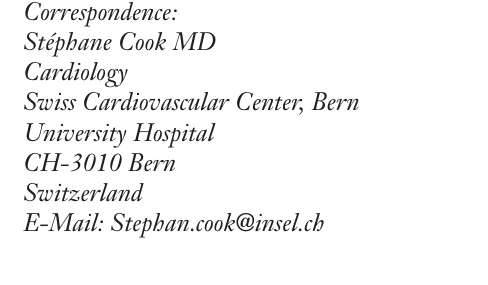
Scheme by which pathological nitric oxide homeostasis can cause metabolic syndrome X. ADMA indicates, asymmet- ric dimethyl arginine (or similar endoge- nous methylated arginines). Redrawn and adapted from Cook et al.